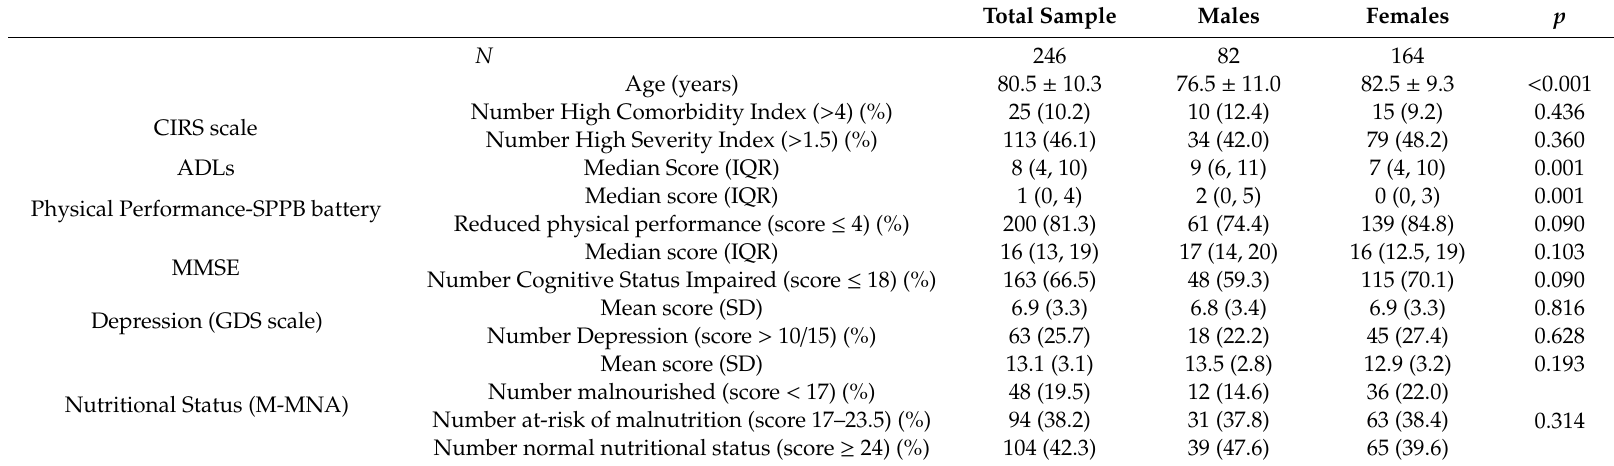
Table 1. Patient clinical, functional, and nutritional characteristics.